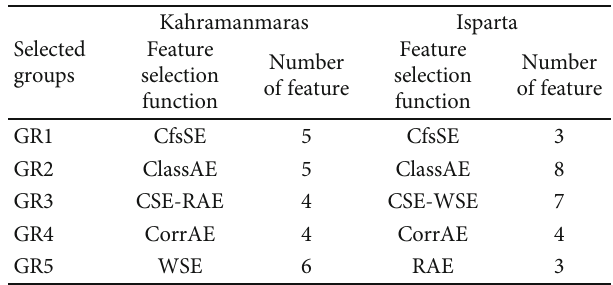
Table 5: Input features a ff ecting the SR the most in Isparta. Feature selection